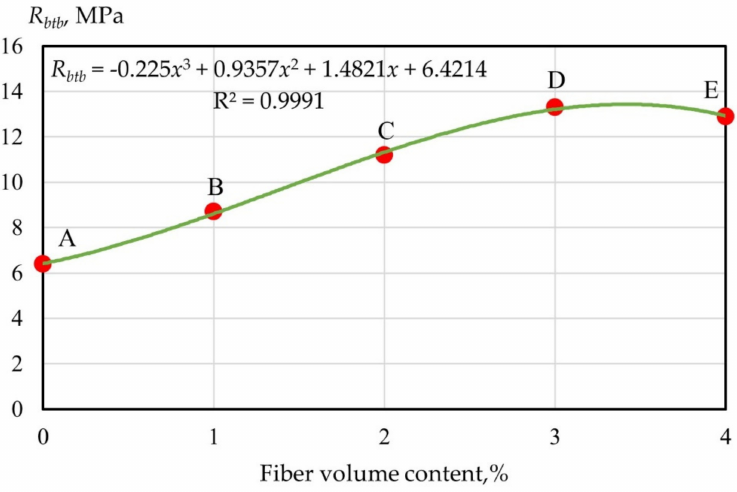
Figure 3. Dependence of the strength of monodispersion-reinforced fiber cement specimens on the volumetric content of glass fiber type